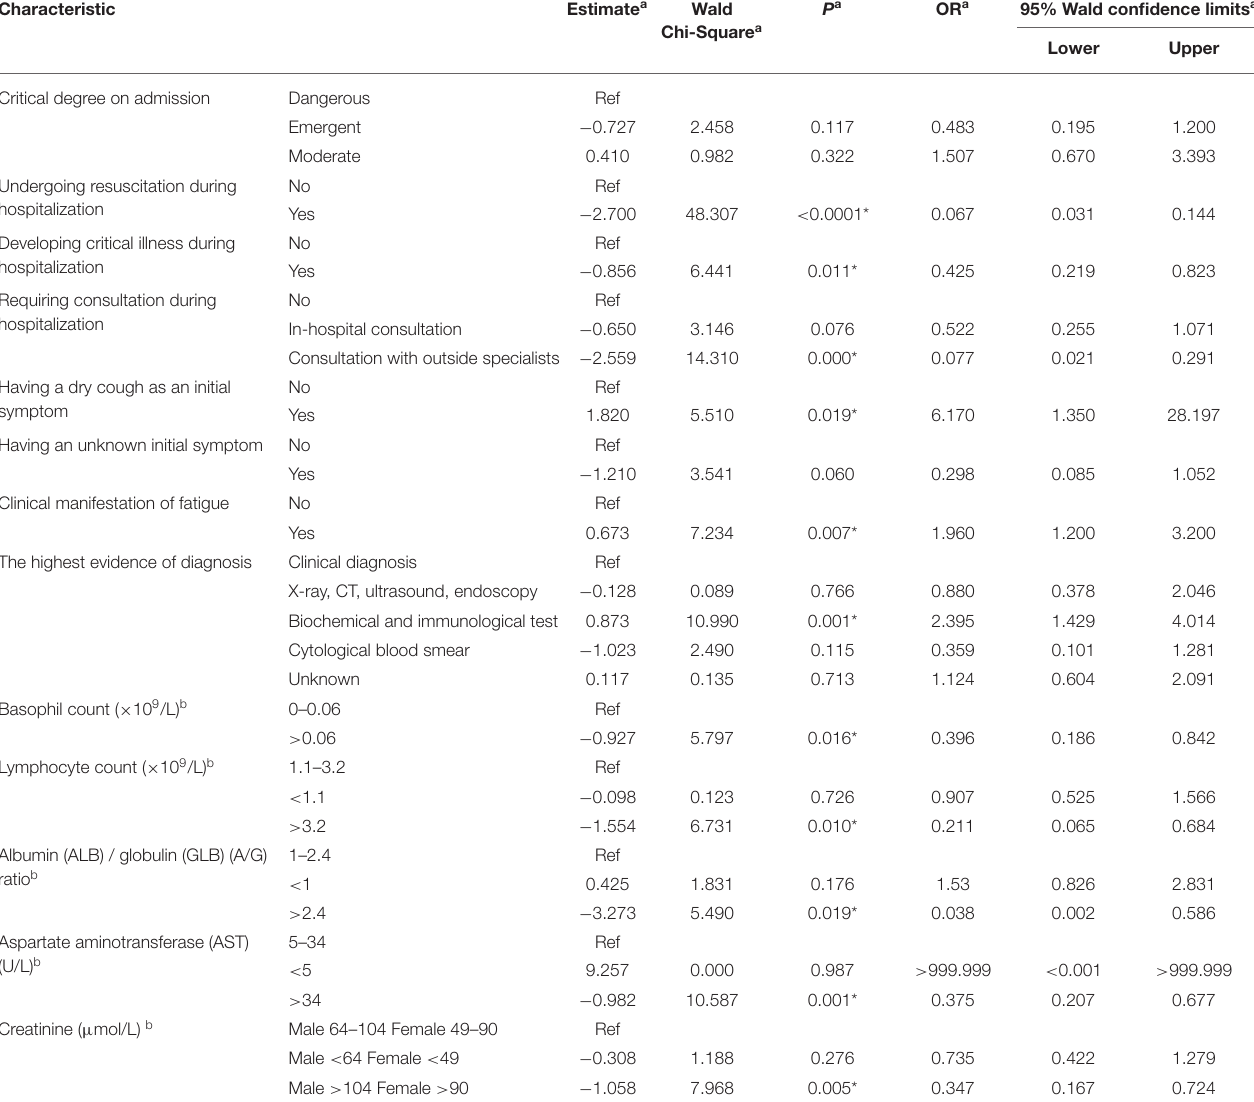
TABLE 2 | Logistic regression analysis of the influencing factors of the prognosis of patients with COVID-19.